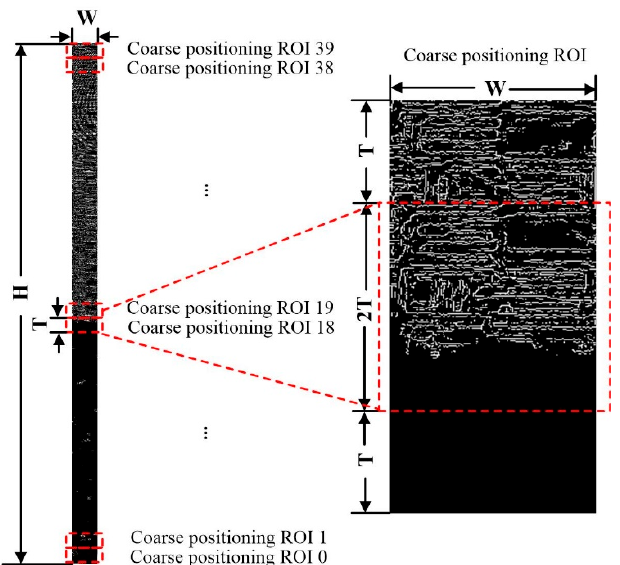
Figure 9. Coarse positioning ROI of water line.